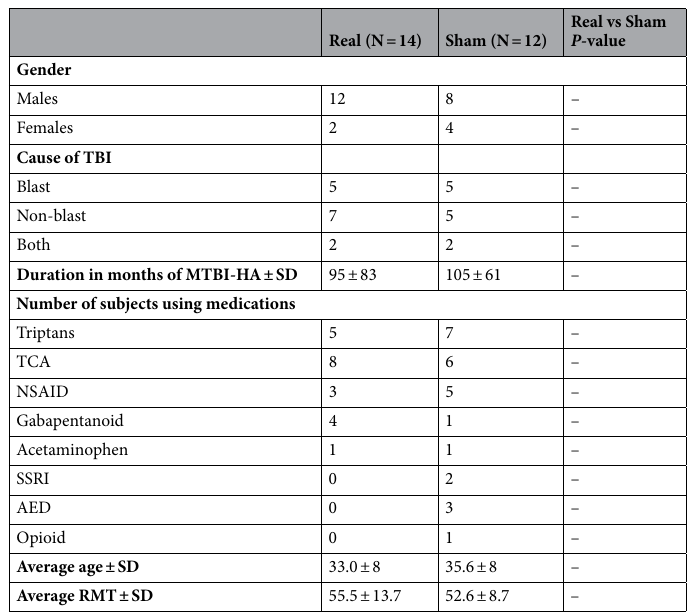
Table 2. Demographic information. RMT Resting Motor Threshold;—no significant difference between